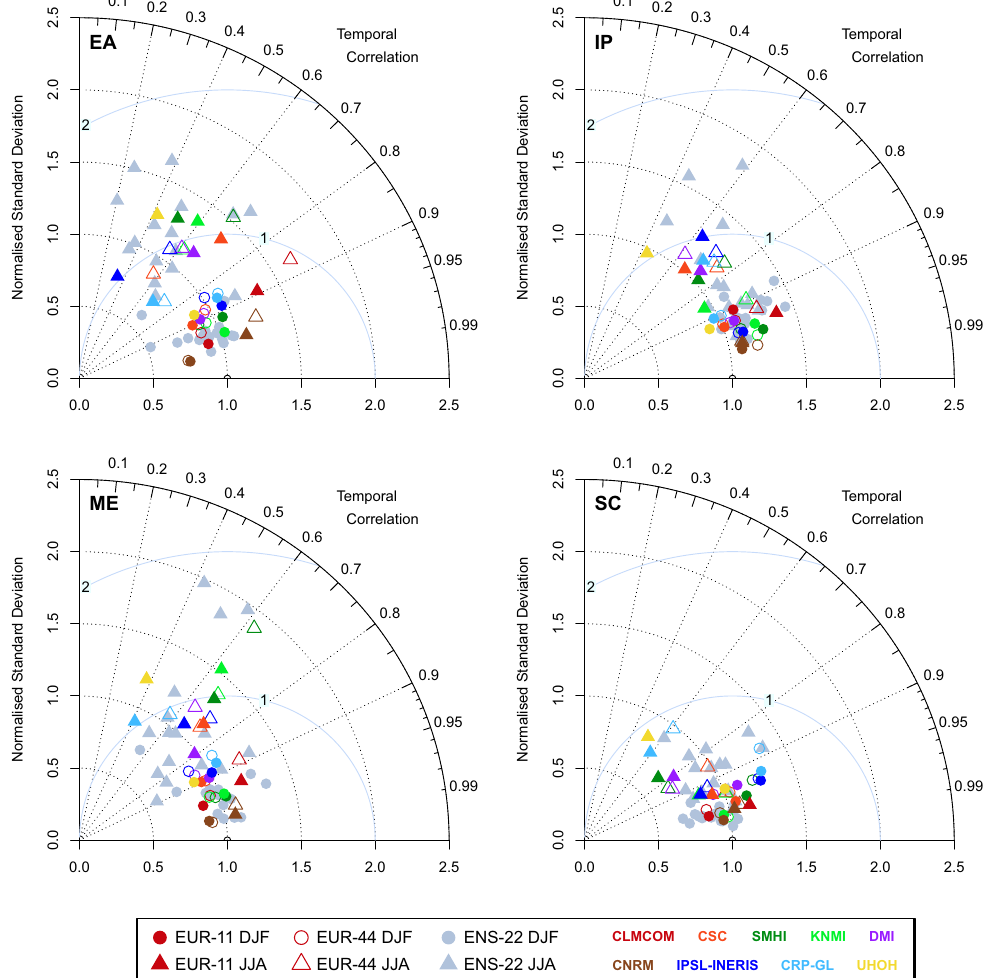
Figure 11. Temporal Taylor diagrams exploring the model performance with respect to the interannual temporal variability of mean winter (circles) and mean summer (triangles) temperature as averages over subdomains EA, IP, ME and SC (see Fig. B7 for subdomains AL, BI, FR and MD). Filled markers: EUR-11 ensemble, nonfilled markers: EUR-44 ensemble, gray markers: ENS-22 ensemble. The diagrams combine the temporal correlation of interannual variability (TCOIAV, cos(azimuth angle)) and ratio of interannual variability (RIAV, radius). The distance from the 1–1 location corresponds to the normalized and centered root-mean-square difference (which does not take into account the mean model bias), expressed as multiples of the observed standard